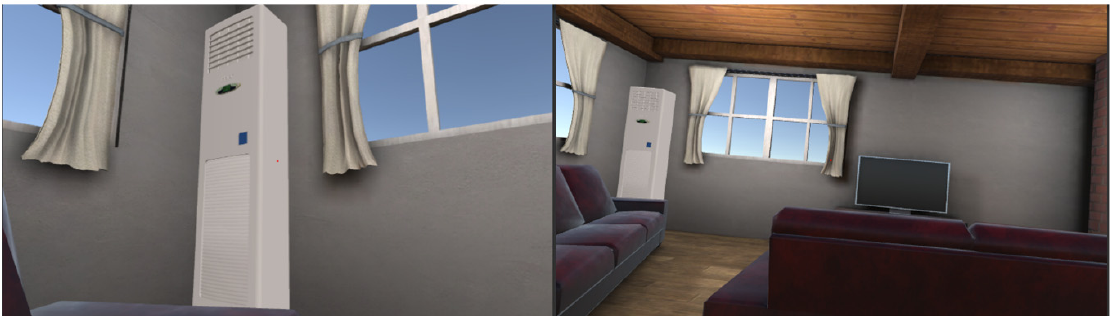
Figure 5. Causes of global warming, such as Freon gas refrigerant from the air conditioning.